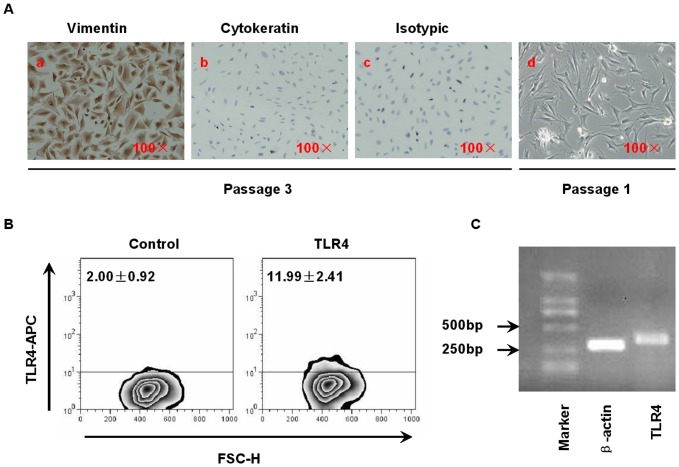
Identification of human first-trimester DSCs.(A) Purity assessment of DSCs by immunocytochemistry. Positive staining is indicated in brown color. (A.a) and (A.b), respectively represent passage-3 DSCs stained with anti-vimentin and anti-cytokeratin antibodies (×100), (A.c) is the isotypic control (×100). (A.d) Freshly isolated DSCs without any treatment (×100). This is a representative photograph from 5 identically conducted experiments. (B) Examination of TLR4 expressed on DSCs. After 48 hours of culture in complete RPMI medium, DSCs were harvested as described in Materials and Methods, stained with an APC-conjugated anti-TLR4 mAb or an isotypic mAb and analyzed by flow cytometry. The data in the figure represent the percentage of DSCs expressing TLR4.The figure is a representative plot based on five independent experiments, each of which was repeated three times. The mean±SD was used to represent the percentage of the population. (C) Detection of TLR4 transcription in DSCs. The DSCs were dissociated, and the otal RNA was extracted for RT-PCR. This is a representative experiment from 5 independent experiments using separate samples.